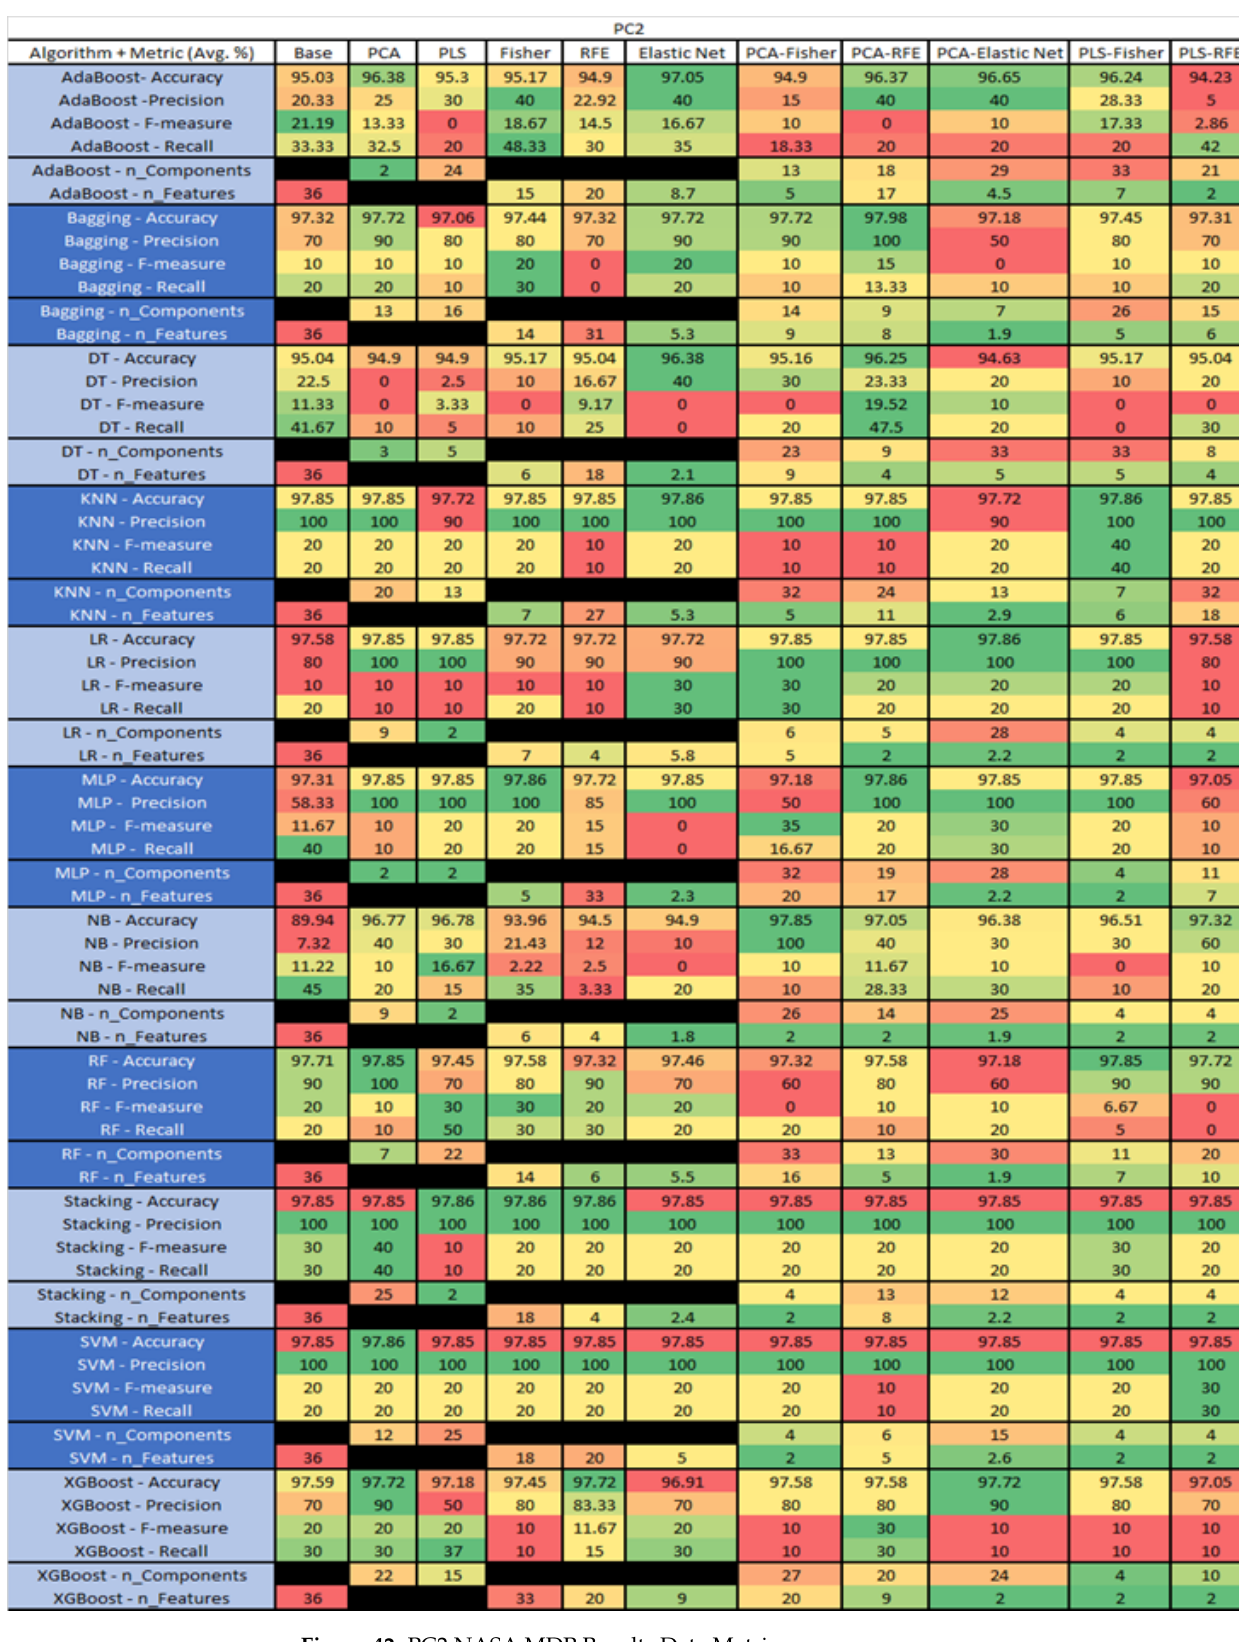
Figure 42. PC2 NASA MDP Results Data